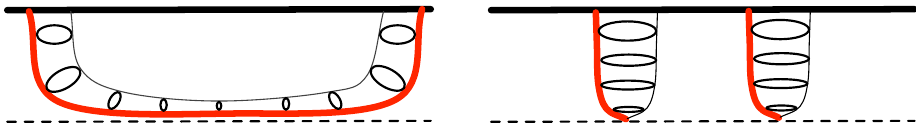
Figure 2 . (Left) Connected membrane con(cid:12)guration in the calculation of the quark-antiquark po- tential in M-theory. The projection of the membrane onto the non-compact directions is represented by the thick, red curve. The M-theory circle at each point is represented next to it by the black circles. The top, continuous, black, horizontal line represents the boundary on which the gauge theory resides. The bottom, dashed, black, horizontal line is the place where the geometry ends smoothly. (Right) Disconnected membrane con(cid:12)guration allowed by charge conservation, since the membrane closes o(cid:11) smoothly at the bottom of the geometry and hence it has a cigar-like topology with no